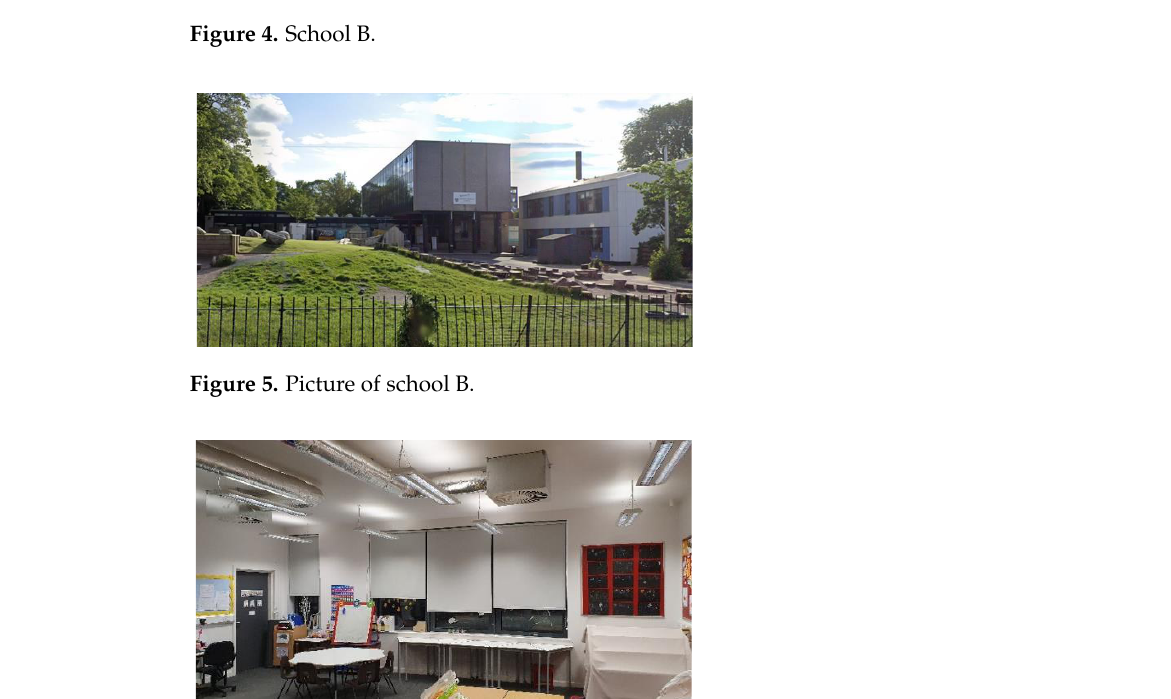
Figure 6. Picture of classroom B1.